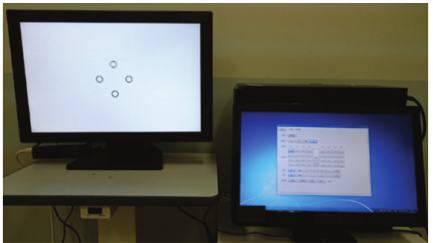
Figure 1: The 3D monitor (3D visual function trainer ORTe) show- ing the overall appearance and targets.